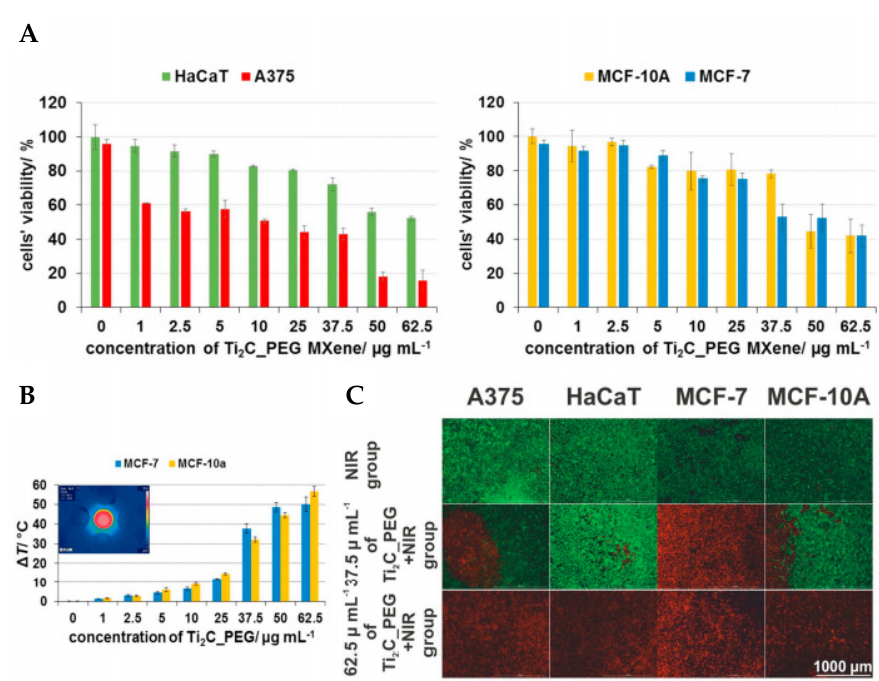
Figure 8. In vitro PTT efficacy ( A ) relative viabilities of HaCaT, A375, MCF-10A and MCF-7 cells after the PTT procedure with the use of various concentrations of Ti 2 C_PEG flakes. ( B ) Comparison of the efficacy of 2D Ti 2 C-PEG as a novel PTT agent with the measured temperature changes for cancer and non-cancer cells on the example of human mammary gland-derived cell lines. ( C ) Exemplary microscopic images after PTT treatment, including the NIR group and groups exposed to various concentrations of the test material and NIR [92].